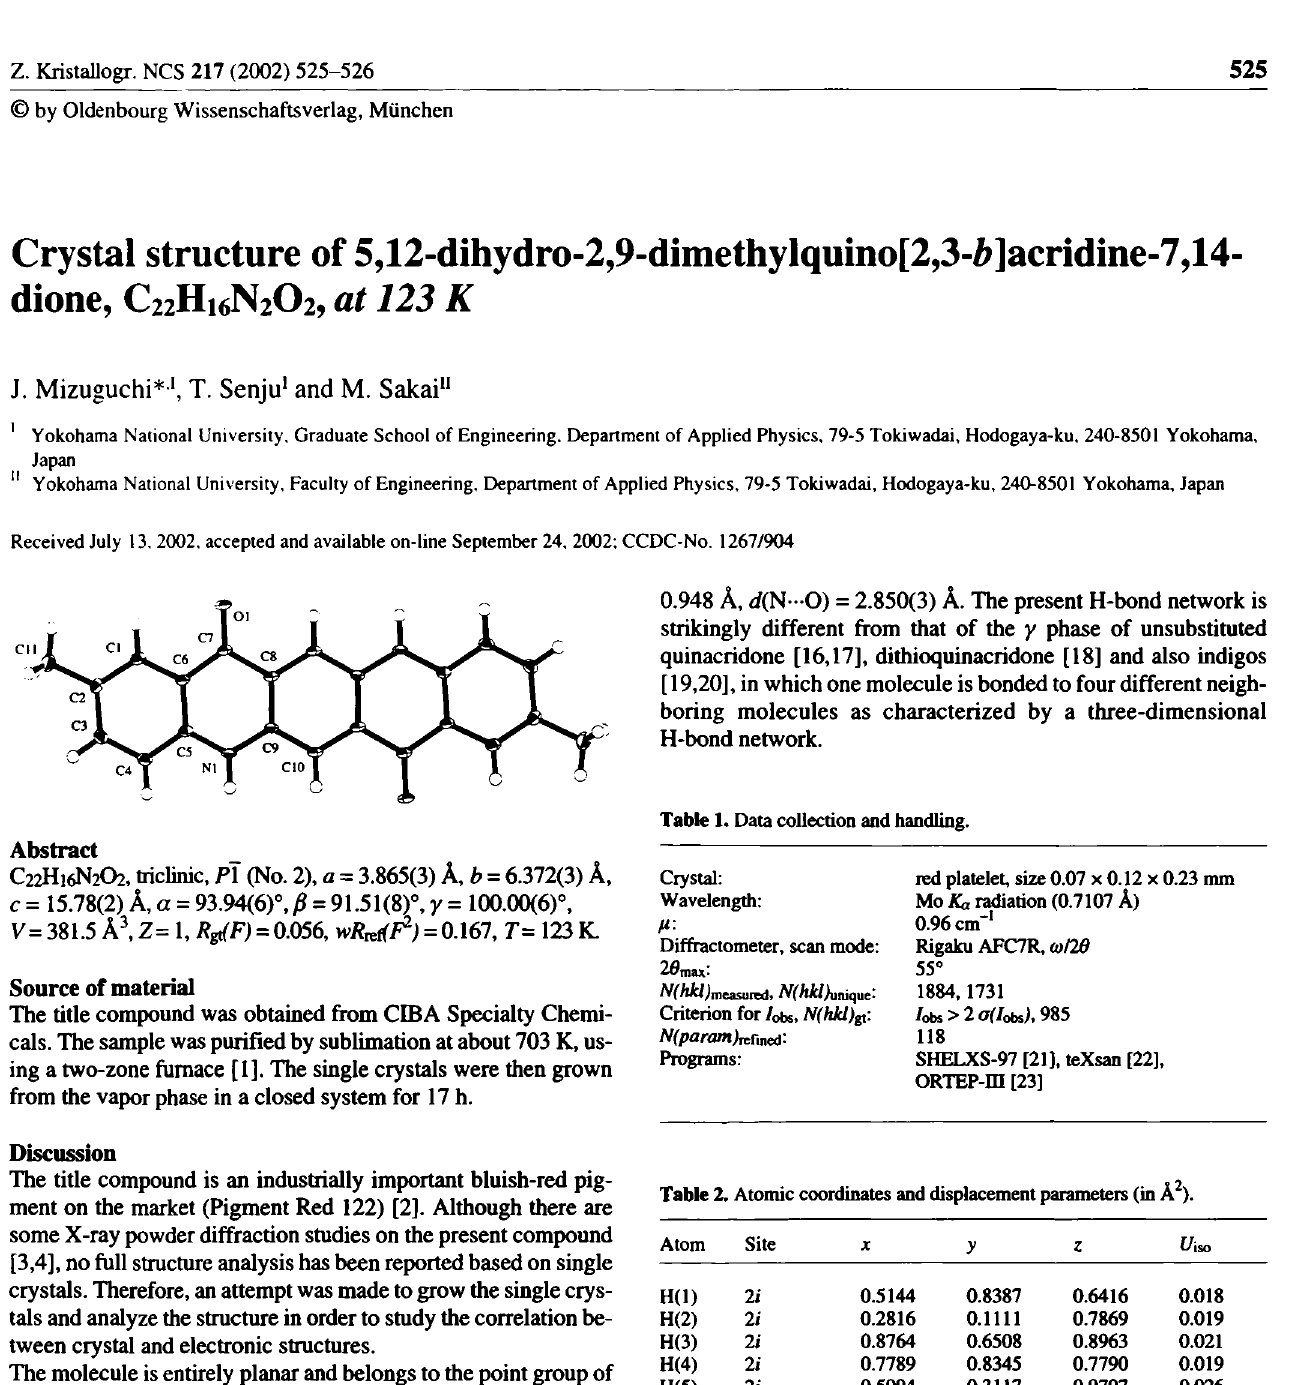
Table 2. Atomic coordinates and displacement parameters (in Ä 2